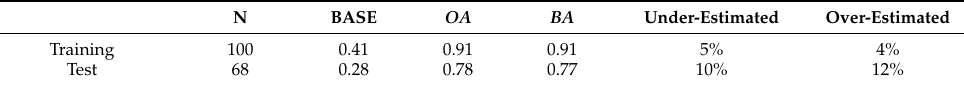
Table 9. Accuracy of N rate prediction using fluorescence features. The baseline accuracy (BASE), overall accuracy ( OA ), and balanced accuracy ( BA ) were calculated from a multi-class confusion matrix. The percentage of cases when estimated N rate was below or above the actual recommended rate is indicated in the under- and over-estimated columns. N BASE OA BA Under-Estimated Over-Estimated Training 100